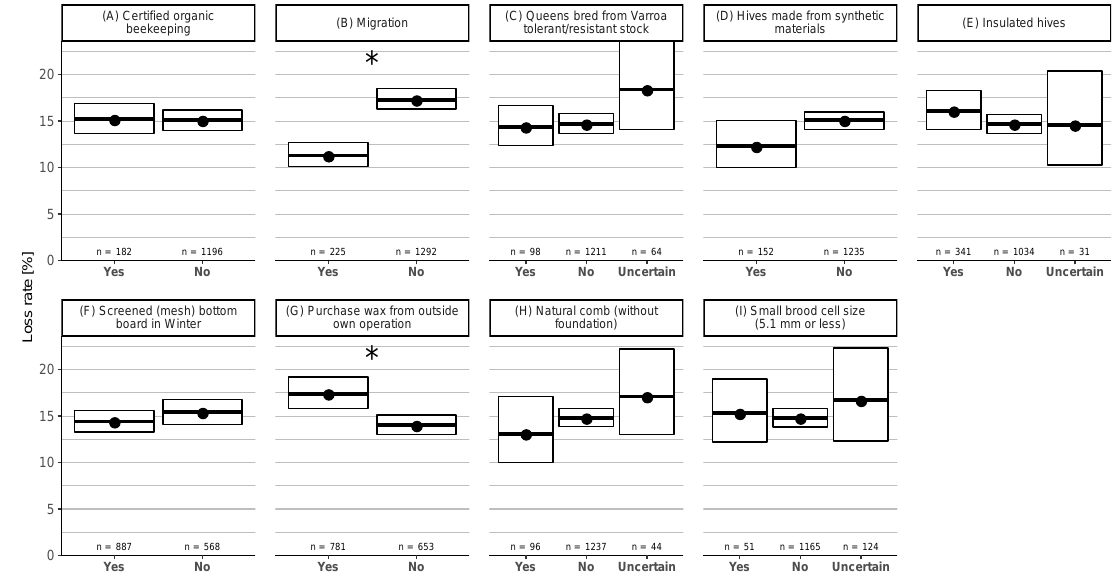
Figure 6. Winter honey bee colony loss rates (and 95% CI) for nine different hive management practices with three possible answers: “yes”, “no”, or “uncertain”. These were compared as single factors to the loss rates. The category “uncertain” was removed from the plot when there were less than 30 answers.